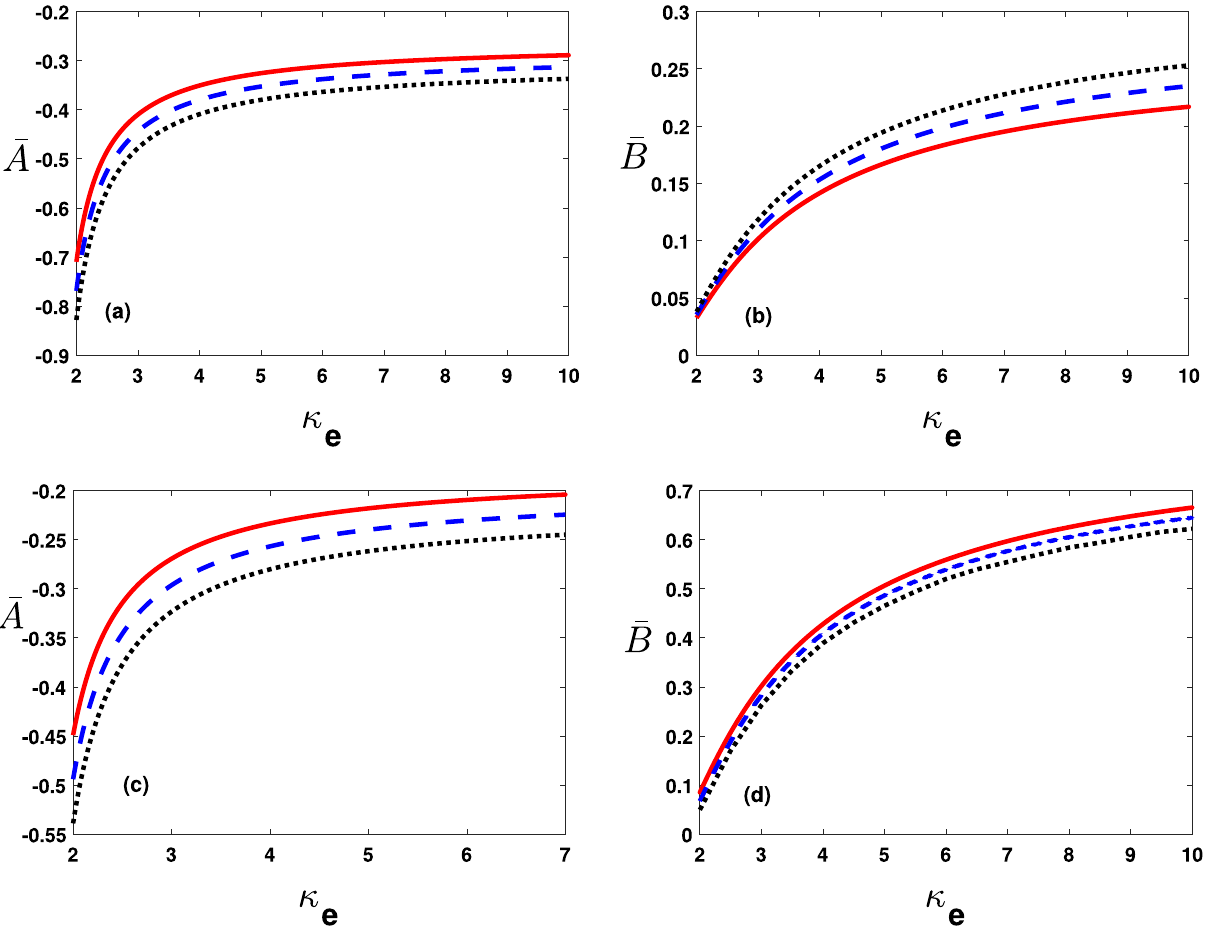
10 − 8 cm 3 s − 1 ) 10 11 cm ( statVs ) − 1 ) and B (= B / B 0 with B 0 ¯ = = 0.6 (solid curve), 0.7 (dashed curve) and 0.8 = 10 12 cm s − 1 (solid curve), × 10 12 cm s − 1 (dotted ×